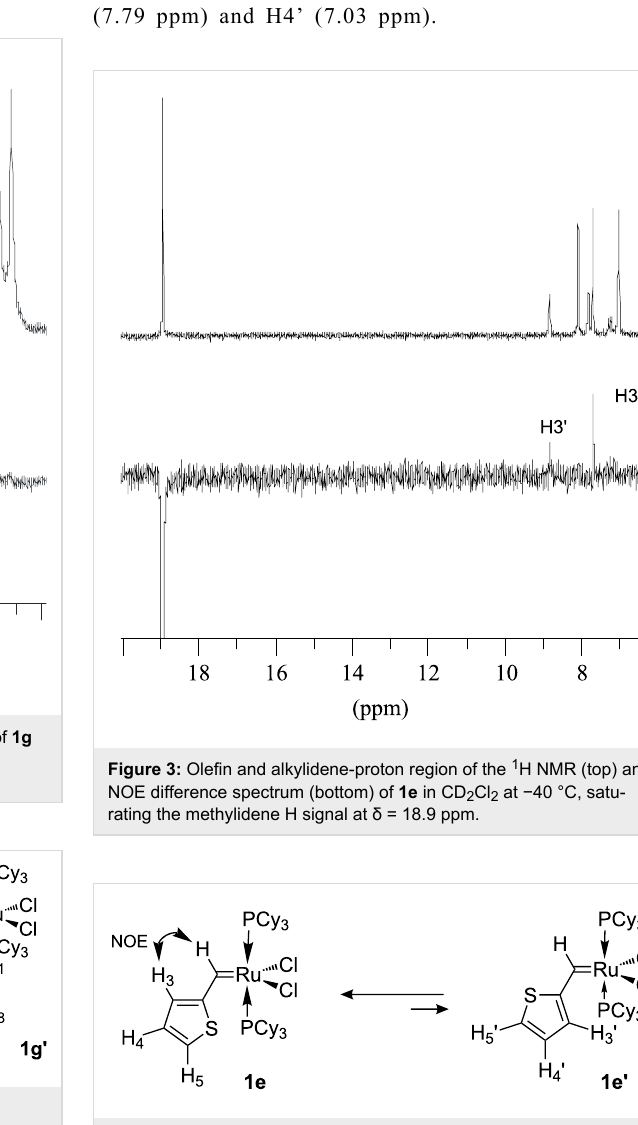
Scheme 5: Conformational isomerism in complex 1e